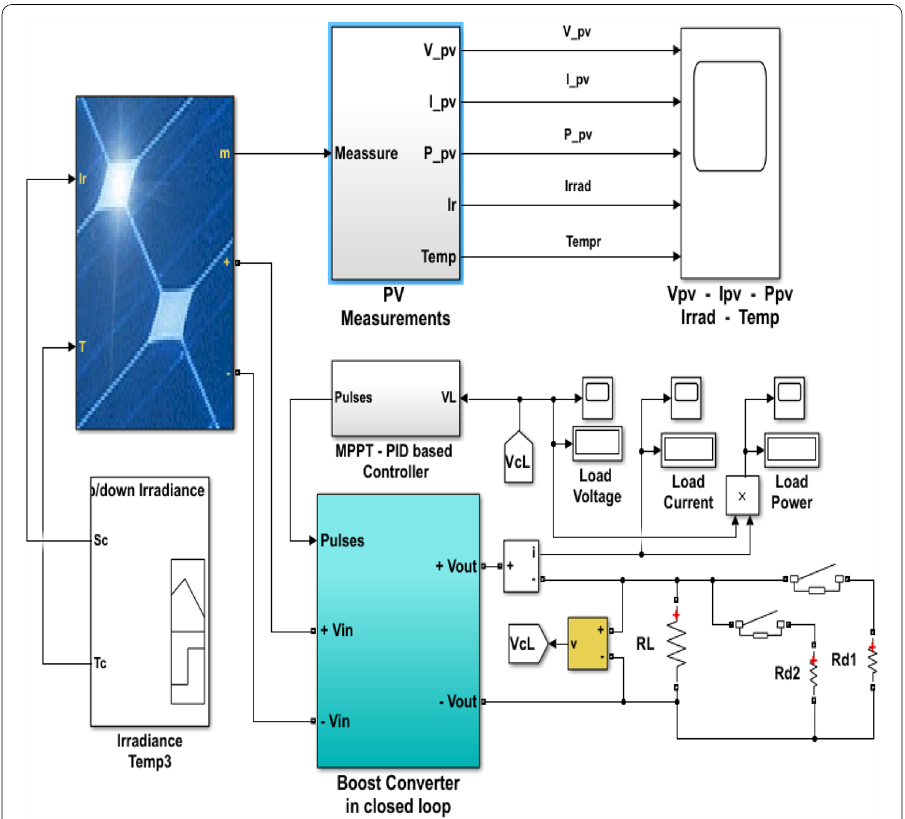
Fig. 11 Simulink model for the stand-alone PV system with MPPT-based PID